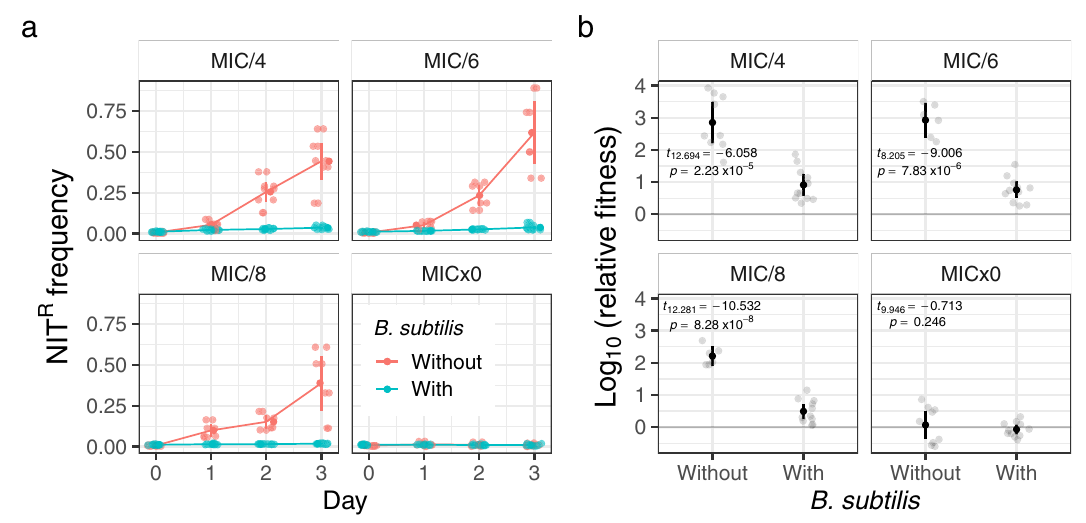
Fig. 1 B. subtilis dampens NIT resistance enrichment in E. coli . a Lines depict increases in frequencies of NIT-resistant (NIT R ) cells over 3 days in the presence of different sub-MIC levels of NIT. b Depiction of log-transformed relative fi tness of NIT R cells in the presence and absence of B. subtilis after 3 days of competition with NIT S cells. Values on each plot represent those after Welch ’ s one-sided t test between log-transformed relative fi tness estimates of resistant strain in the presence and absence of B. subtilis for each antibiotic concentration. The log-transformed relative fi tness value of zero (gray horizontal line) represents no fi tness advantage to either NIT R or NIT S strains, while positive values indicate an advantage to NIT R strains. Lighter points depict individual replicates, darker points represent means and error bars represent 95% con fi dence intervals ( t -distribution, n = 12 for both